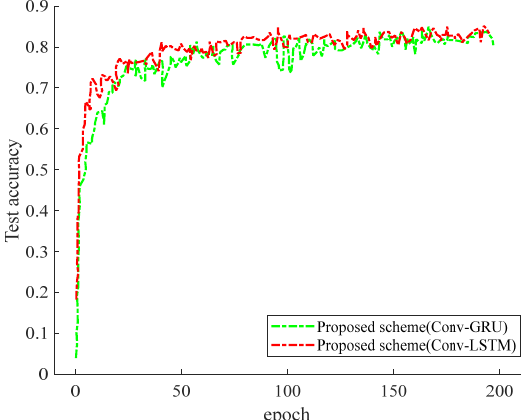
Figure 14. Comparison of the accuracy performances of Conv-GRU and Conv-LSTM prediction schemes.